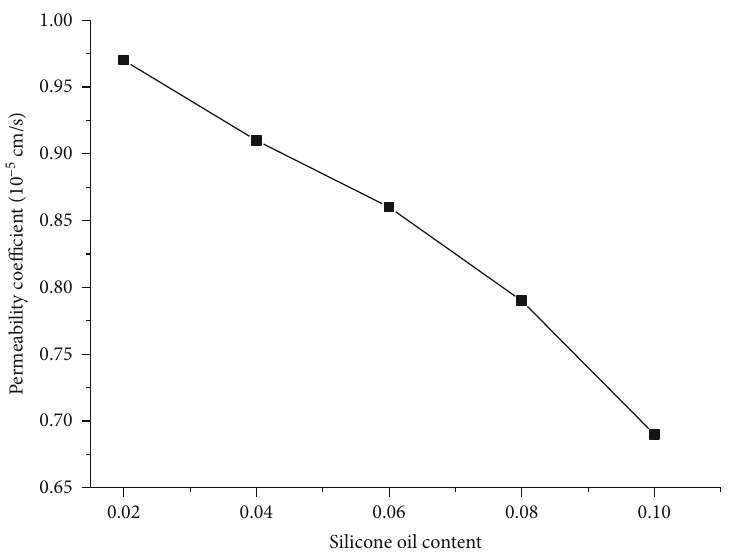
Figure 10: E ff ect of silicone oil on permeability coe ffi cient of materials. Table 5: Proportion of model